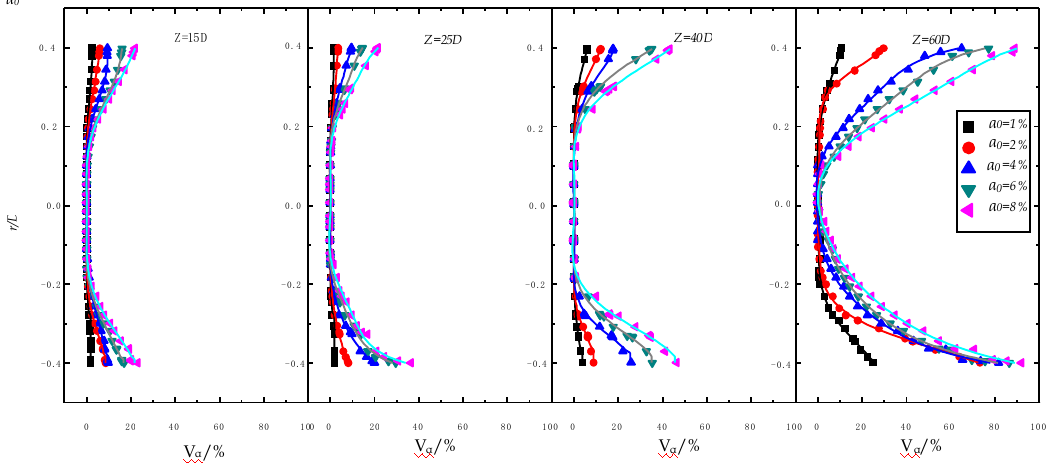
Figure 18. Graph of particle volume fraction at each section at Re = 20,000 with a twist ratio of 6.2.